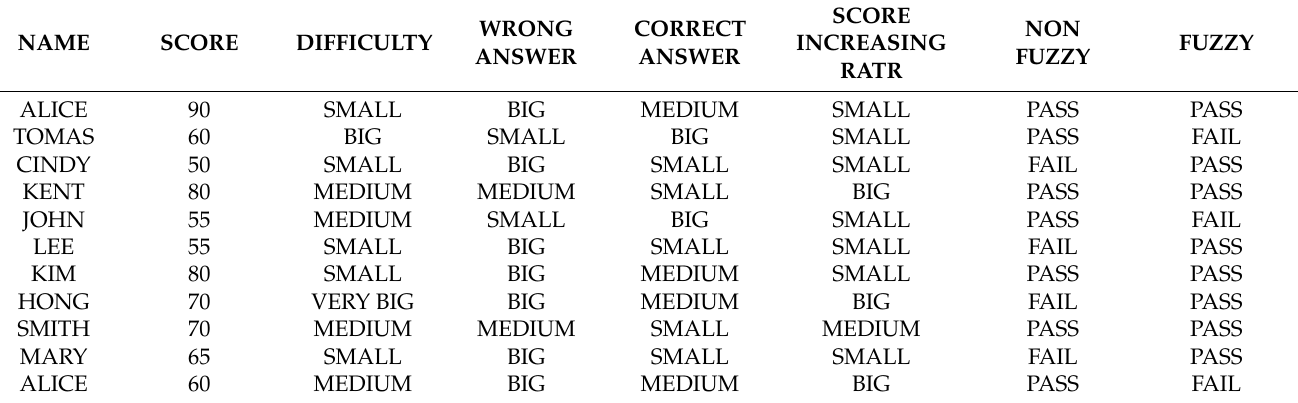
Table 2. Simulation results of automatic judgment of learning by level based on incorrect answer